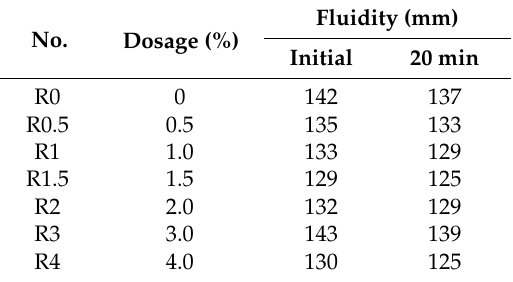
Table 4. E ff ect of RP on the fluidity of